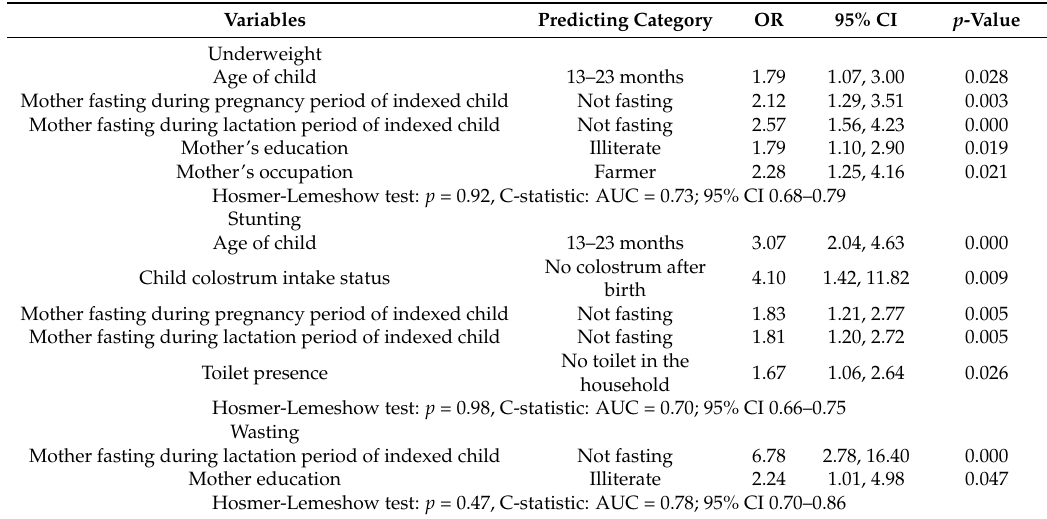
Table 3. Multivariate logistic regression: associated factors of malnutrition of 6–23-month-old children regarding underweight, stunting and wasting in rural Tigray, Ethiopia ( N =